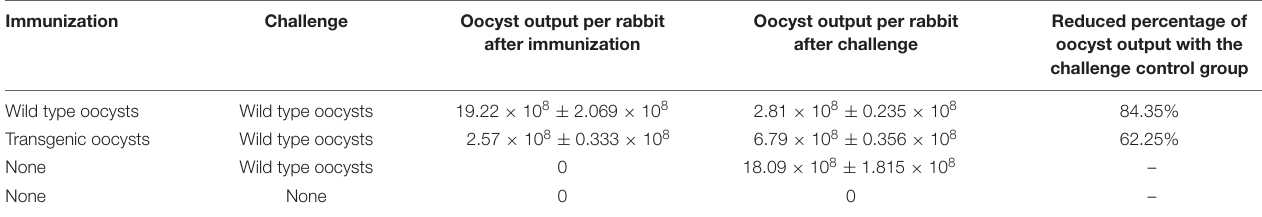
TABLE 1 | Oocyst output in rabbits (mean ± SD; n = 4) after immunization with sporulated wild type or transgenic oocysts (5 × 10 3 ) and challenged with the wild type oocysts (1 × 10 6 ) of Eimeria intestinalis. Immunization Challenge Oocyst output per rabbit